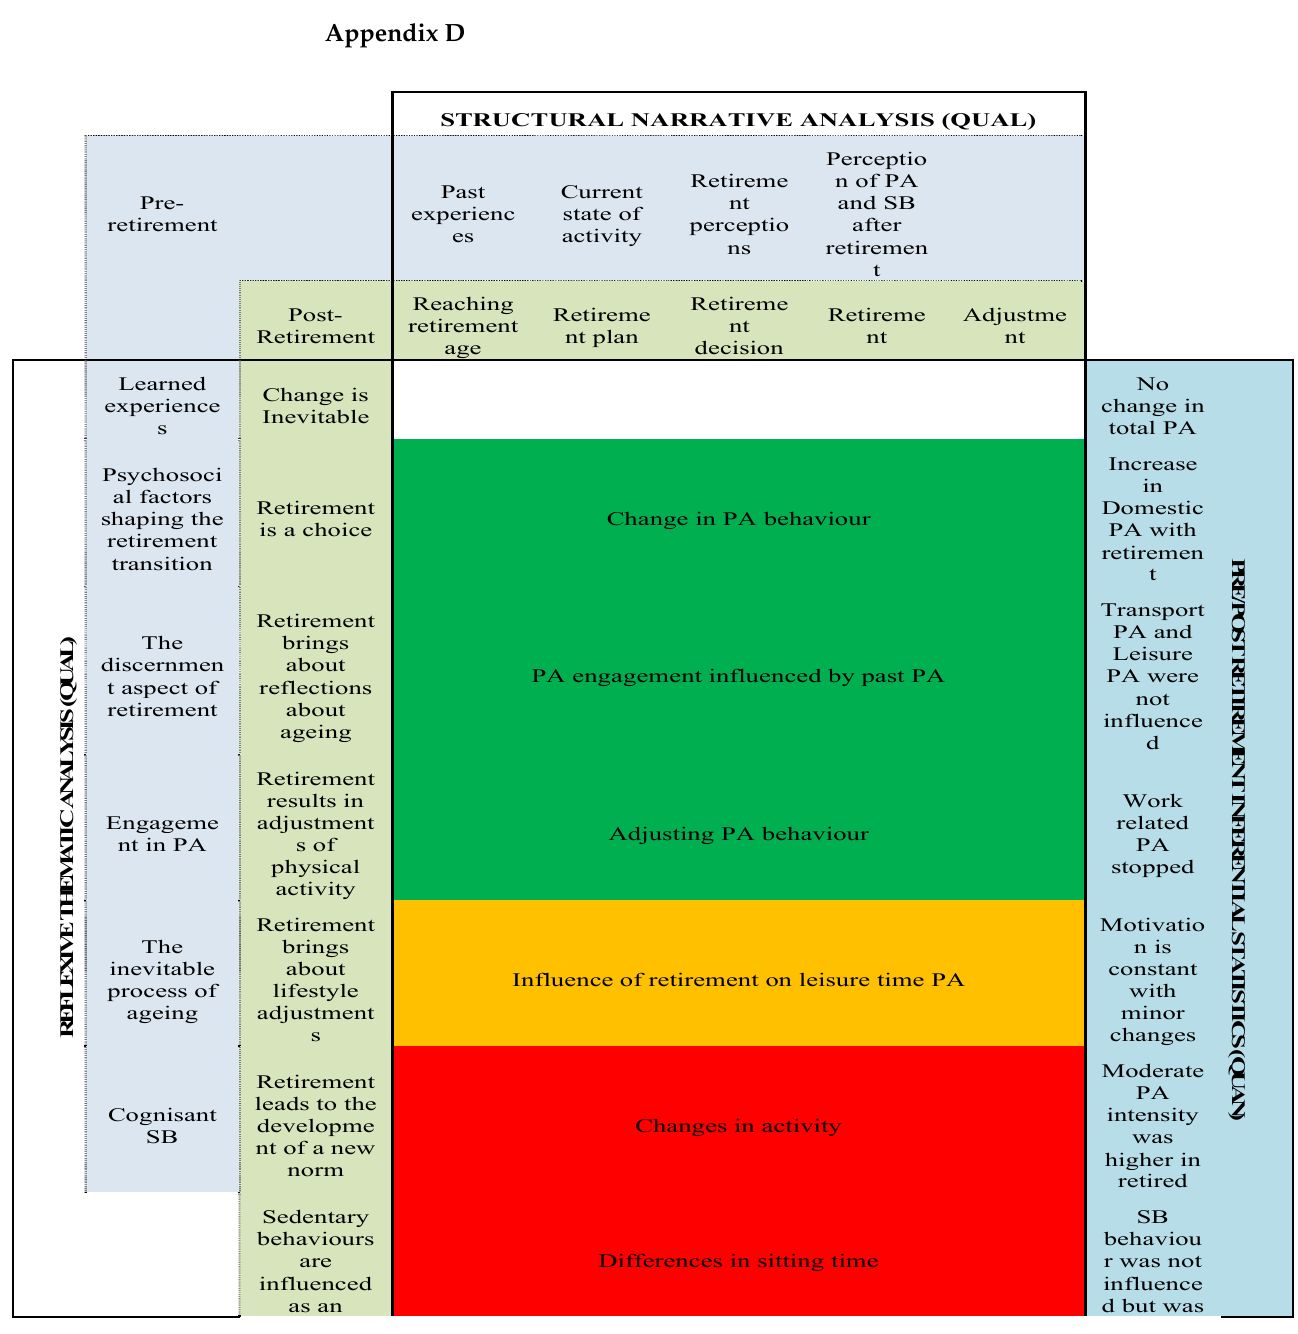
Figure A1. Integration of MM results.